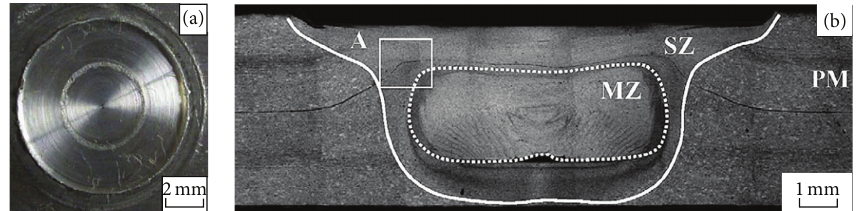
Figure 7: Macroscopic appearance of a FSSW joint with refilled probe hole: (a) top view of weld zone and (b) cross-section of weld zone [20].